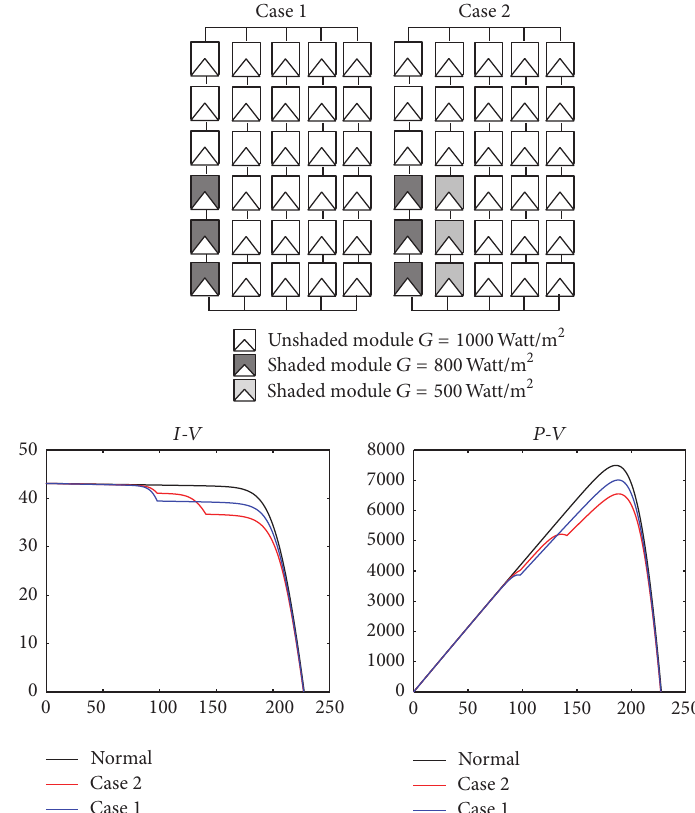
Figure 4: The PV array configuration for shading.